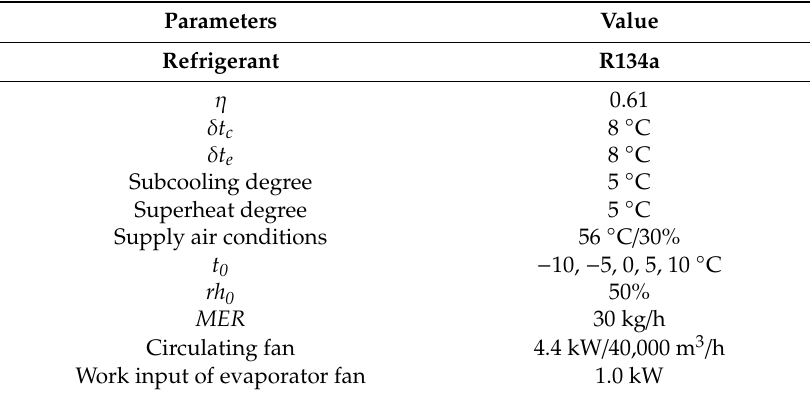
Table 1. Setting